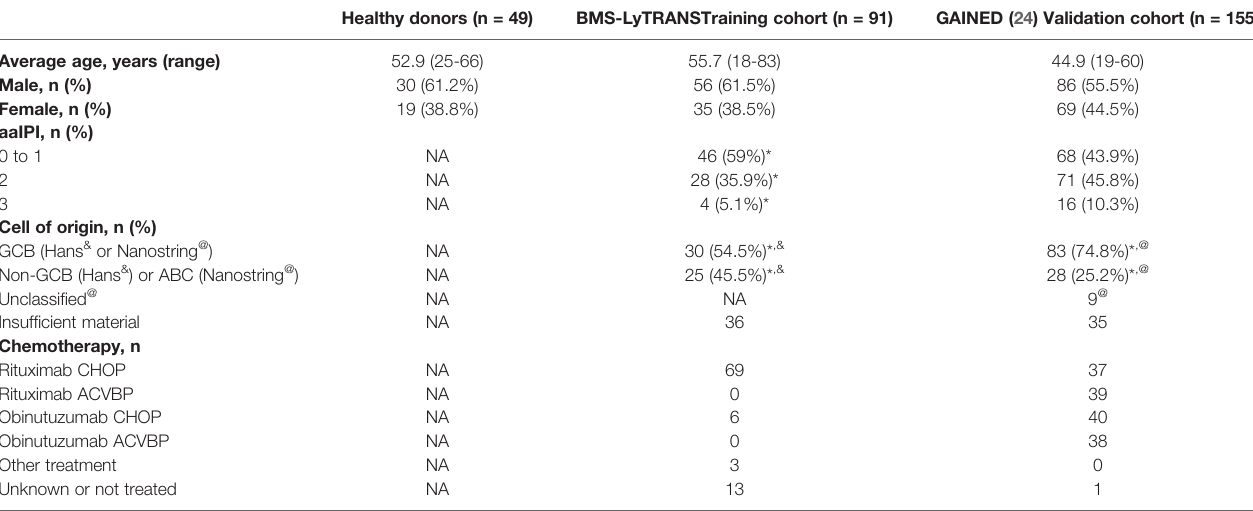
TABLE 1 | Patient ’ s characteristics at